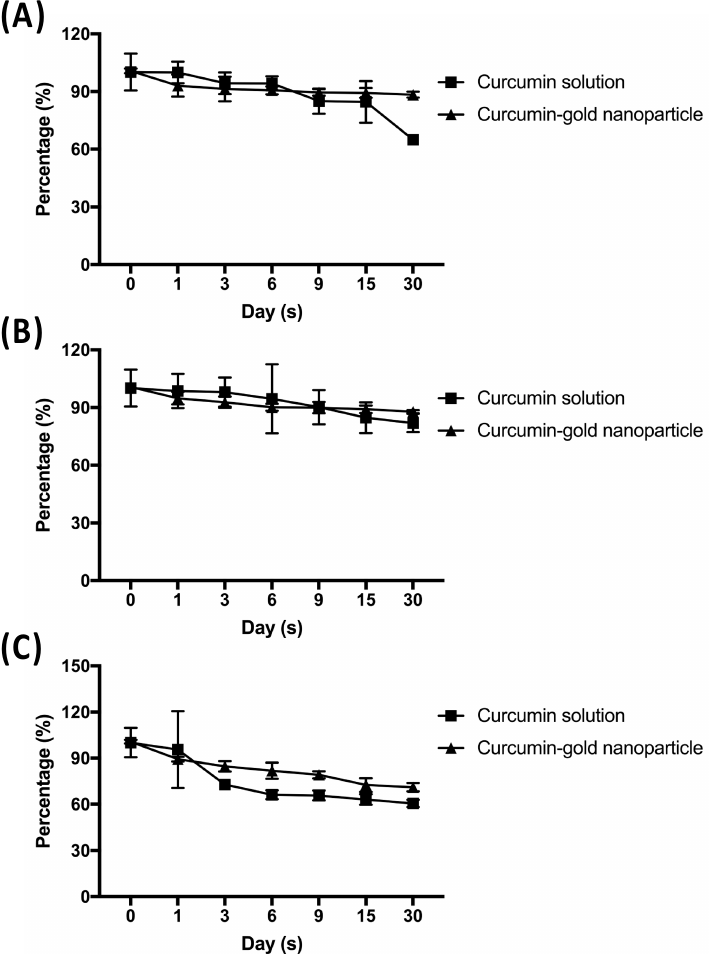
Figure 6. Curcumin and curcumin-gold nanoparticles concentration at 5 °C ( A ), 25 °C ( B ), and 40 °C ( C ) for 1 month.